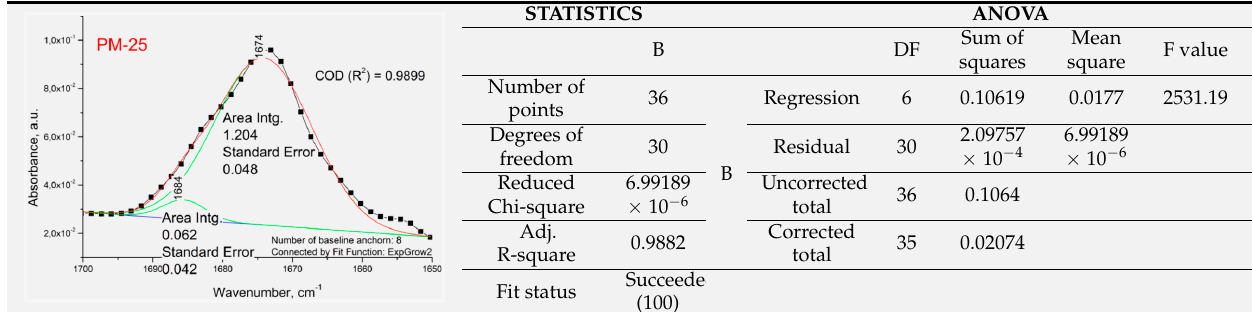
Table A5. Sample P-25.